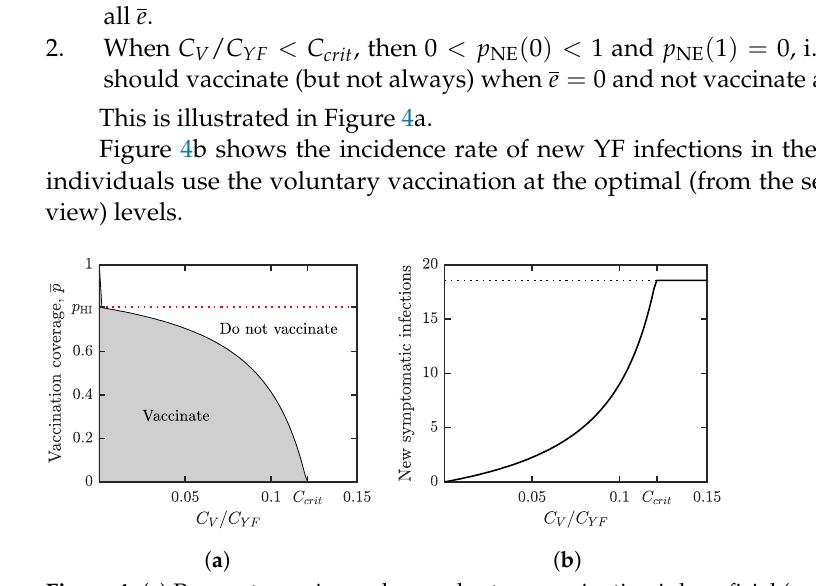
Figure 4. ( a ) Parameter regions where voluntary vaccination is beneficial (gray) and not beneficial (white). The boundary between the two regions represents the optimal voluntary vaccination coverage, p NE . The red dotted line is the vaccination coverage needed for herd immunity, p HI . As C V / C YF increases, p NE decreases while p HI remains constant. When C V / C YF reaches the critical level C crit given in (25), p NE becomes 0. At that point, the relatively high vaccine cost makes “do not vaccinate” an optimal strategy from the individuals’ perspective. ( b ) As C V / C YF increases, the difference between p HI and p NE grows. This means that the number of price of anarchy increases. When C V / C YF reaches the critical level C crit , p NE becomes 0 and the price is maximal (shown by the dotted line). For our scenario, we evaluated the price of anarchy as the number of new symptomatic yellow fever infections per year per 10 4 population when individuals use the Nash equilibrium level of protection. In both figures, e = 0 and the values of all other parameters are as in Table